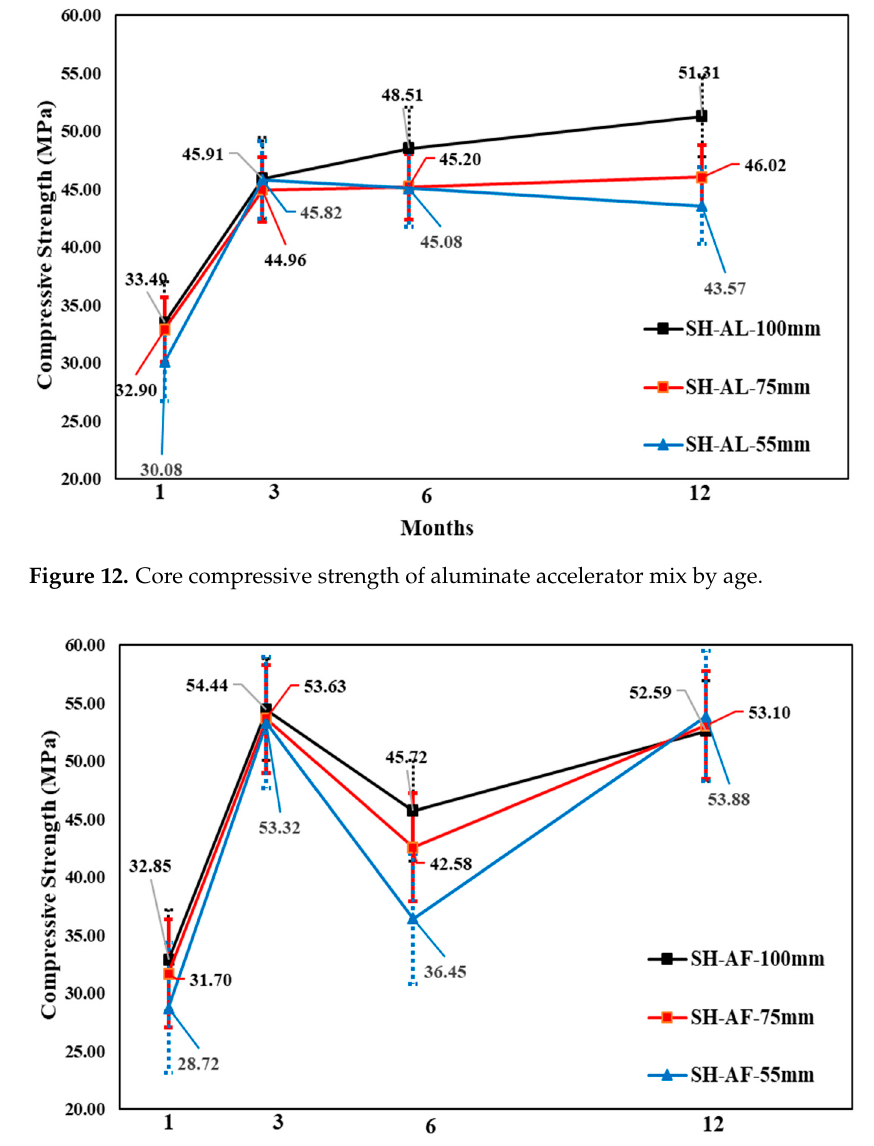
Figure 11. Core compressive strength of cement mineral accelerator mixture by age.